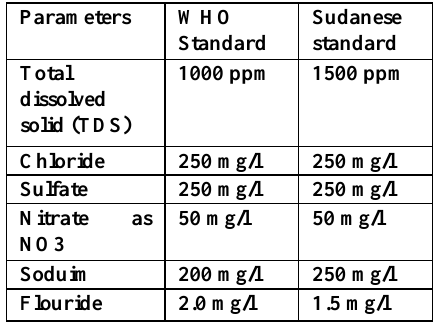
Table :(1)Drinking water: Parameters and Recommended Permissible